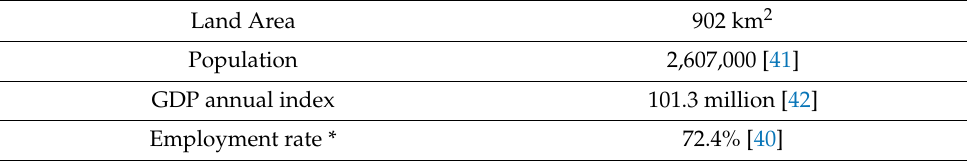
Table 1. Summary of WM socioeconomic status. Table 2. Fleet distribution according to the fuel type. These data were extracted from the National Atmospheric Emission Inventory [43]. MC and PSV are corresponded with motorcycles and public service vehicle, respecively.